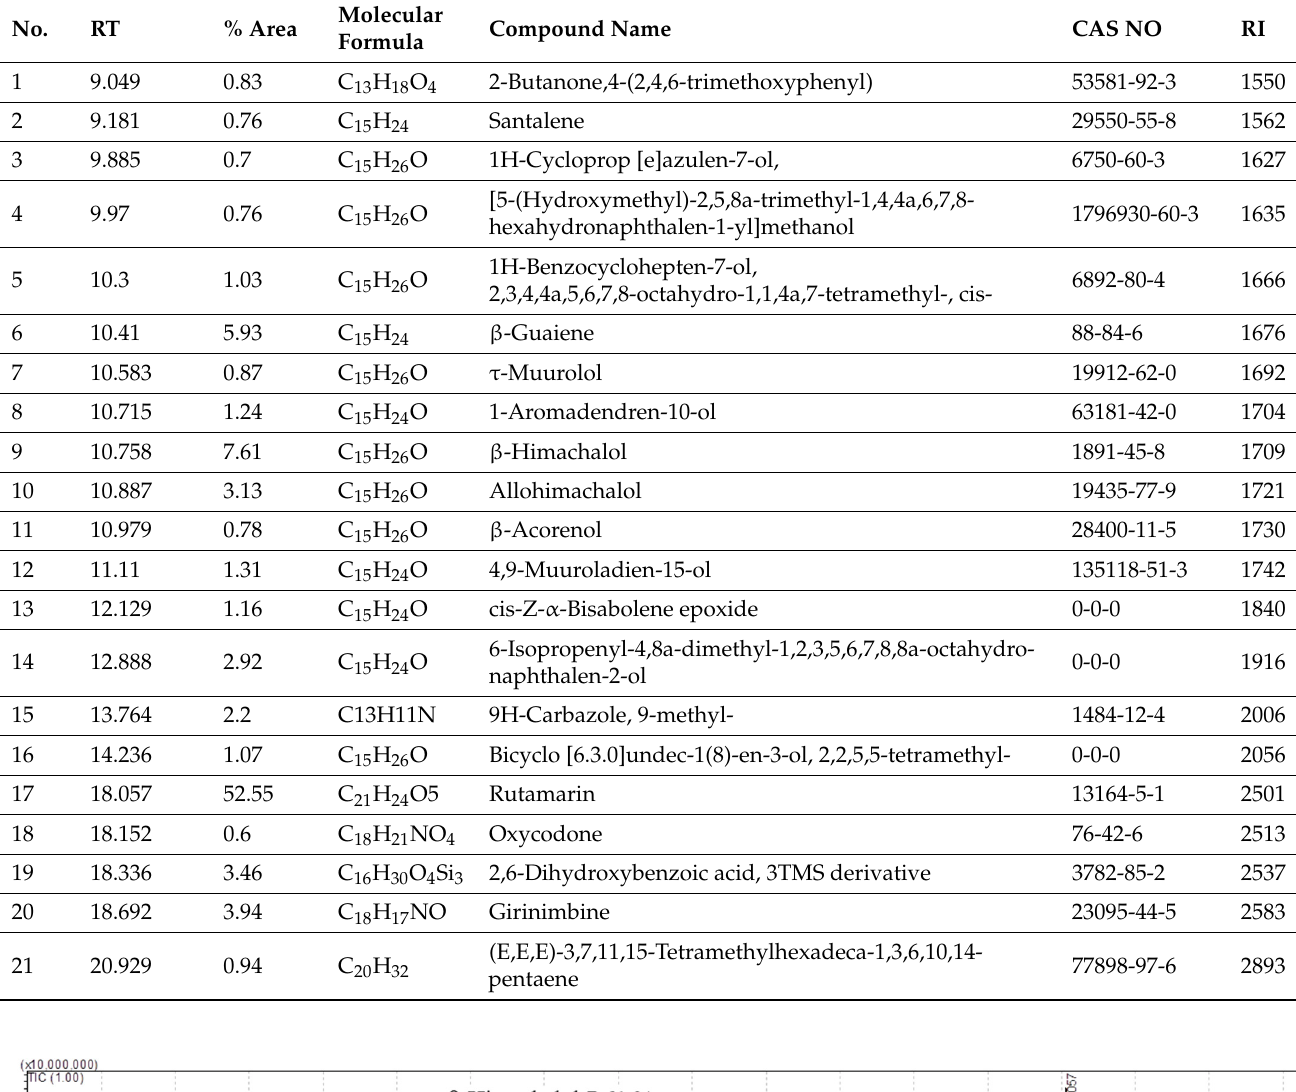
Table 11. Phytocompounds identified in isolated non-volatile oil B from the root bark of T. Ciliata by GC-MS/MS.